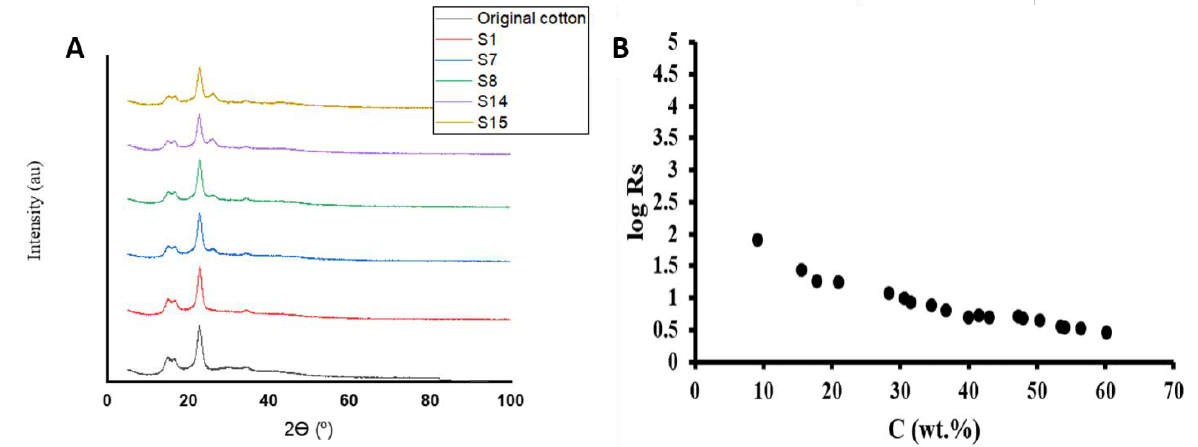
Figure 3. ( A ) XRD analysis of the untreated cotton and the cotton treated with different nanocom- posite concentrations (S1 = 28.42 wt%, S7 = 41.62 wt%, S8 = 43.14 wt%, S14 = 56.53 wt%, and S15 = 60.27 wt%); ( B ) Logarithm of the resistance of the conductive cotton fabric as a function of nanocomposite.